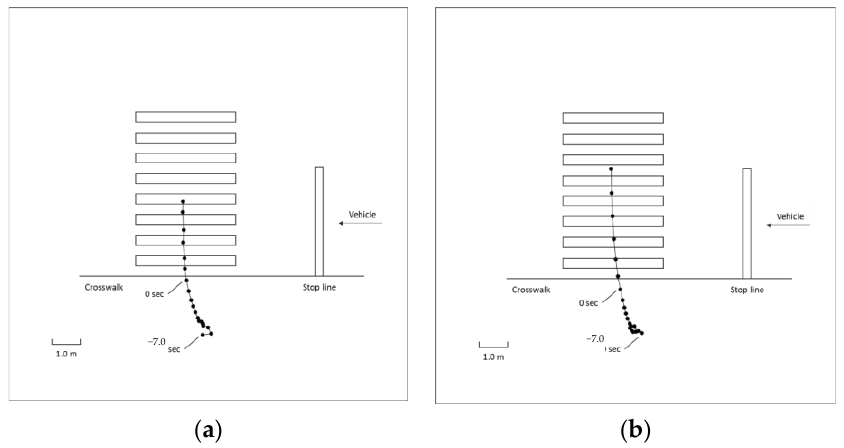
Figure 7. Average positions of pedestrian in Group 2a (high perceived safety) and Group 2b (low perceived safety). ( a ) Group 2a. ( b ) Group 2b.